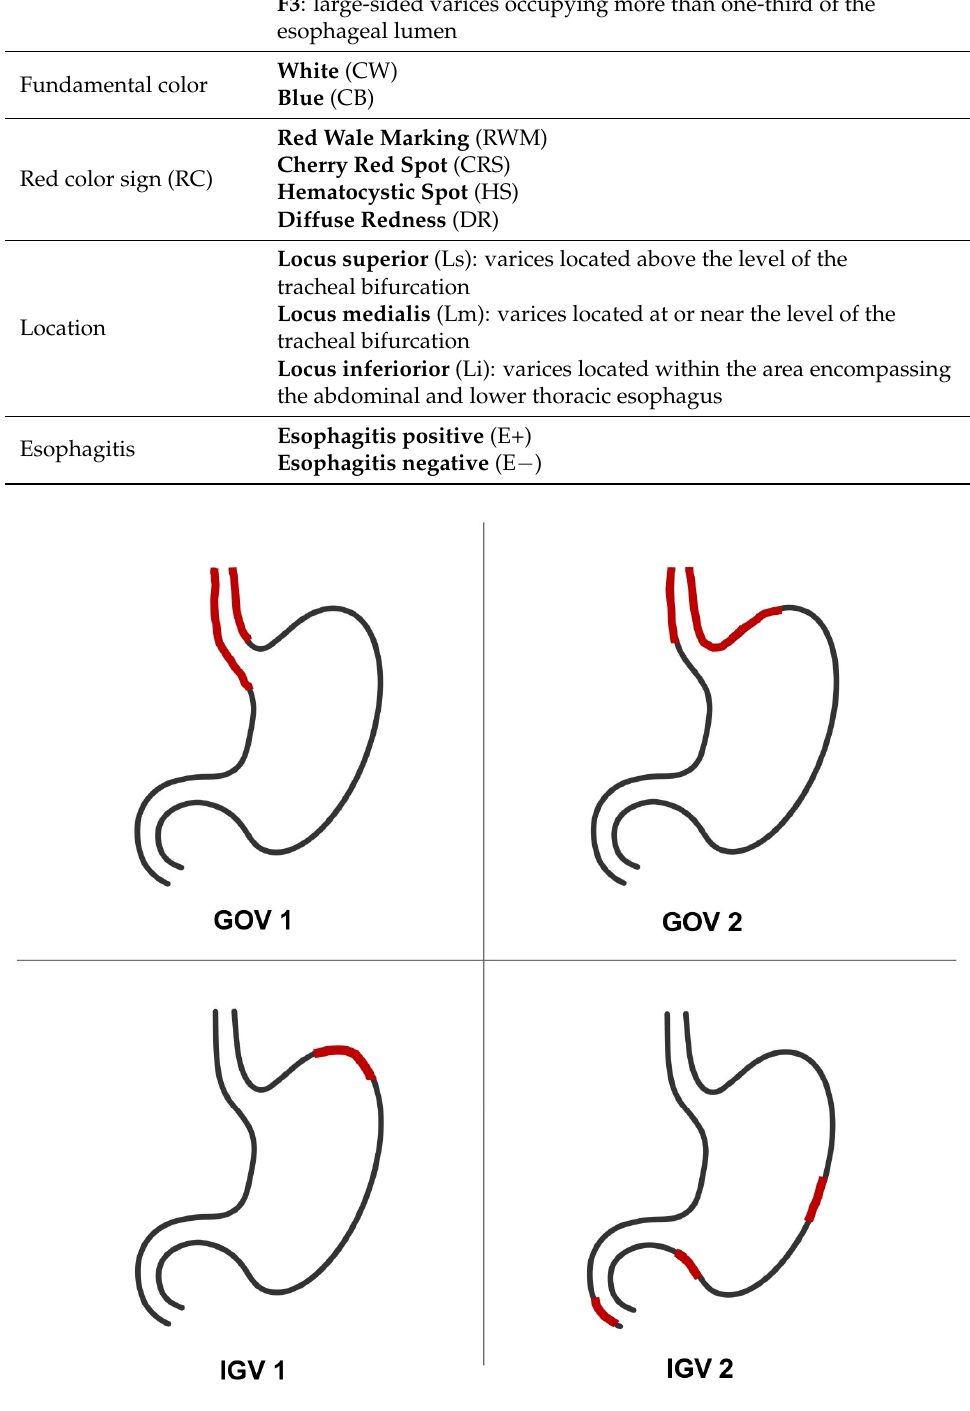
Figure 2. Illustration of different types of gastric varices according to the Sarin classification (GOV: gastroesophageal varices; IGV: isolated gastric varices) [13].